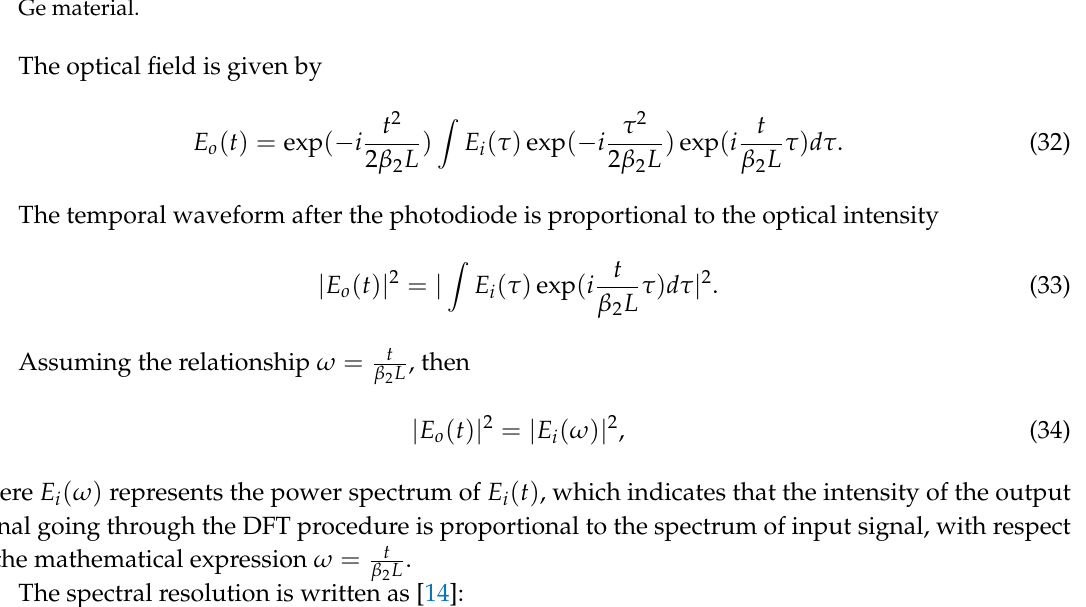
Figure 12. Block diagram for high-throughput single-shot spectroscopy. The prism pair is composed of Ge material.